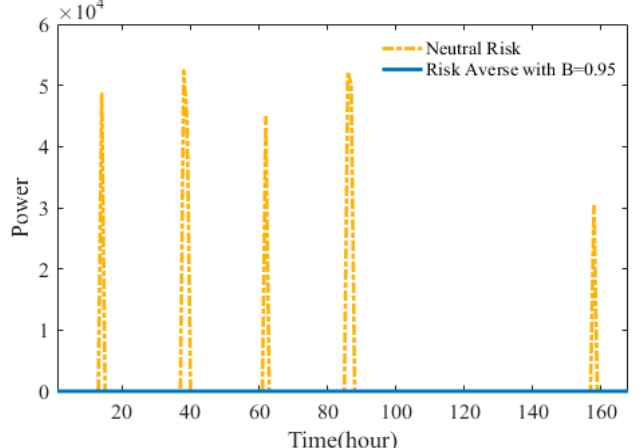
Figure 10. Transferred power from the PV to the grid.